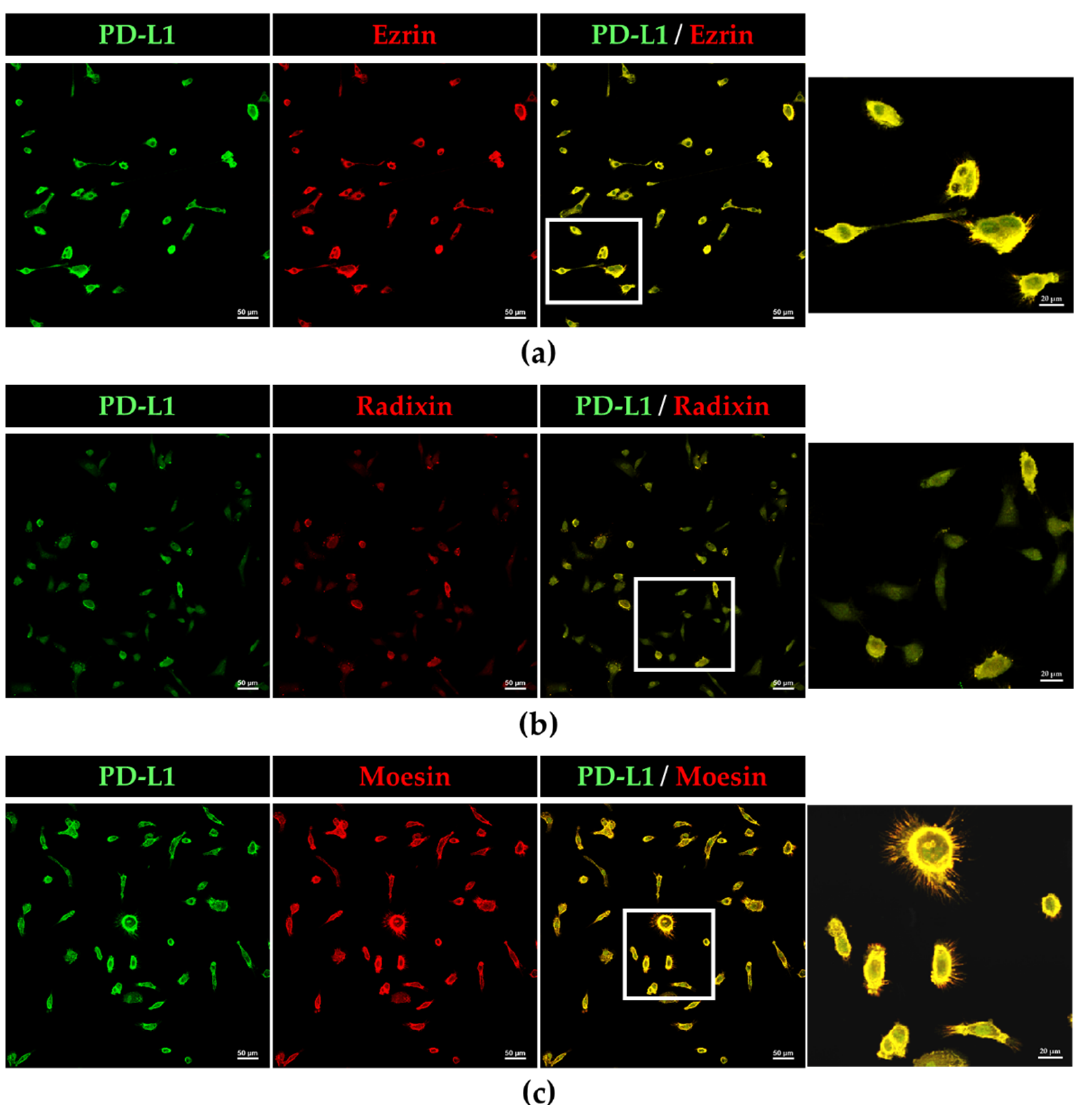
with Alexa Fluor 488 (green) highly colocalized with F-actin labeled with tetramethylrhodamine (red). Scale bars: 50 µm. Higher magnification images in the rightmost are from the corresponding white rectangle region in the merged panels. Scale bars: 20 µm. All images are representative of at least three independent experiments.